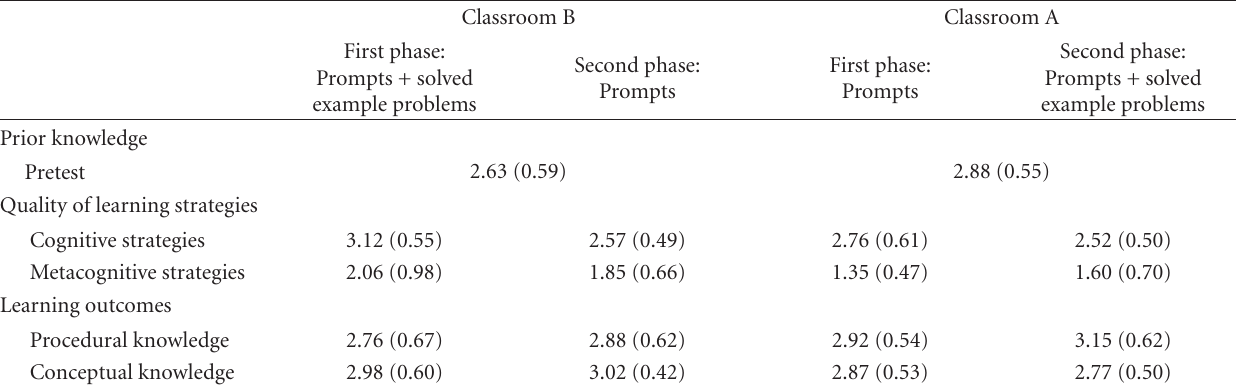
Table 2: Means and standard deviations (in parentheses) of the pretest, quality of learning strategies, and posttest scores in the two phases of the